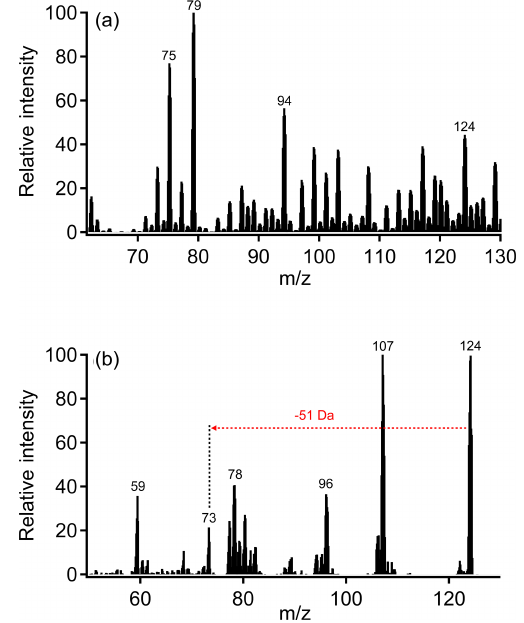
Figure 4. (a) Mass spectrum of reaction of methylglyoxal with H 2 O 2 in the presence of AA; (b) product mass spectrum of m/z 124 from panel (a) .